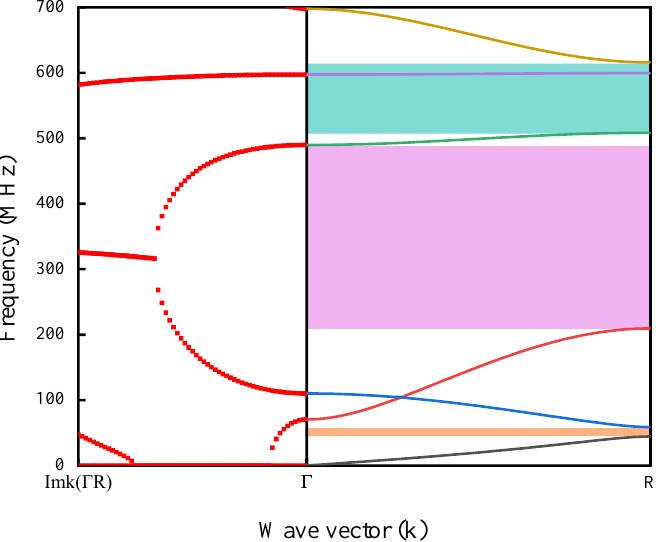
Figure 2. Complex energy band curve of the H-RPC structure. The real wave vector energy band curve in ( Г -R) direction is represented by solid lines of different colors on the right side, and the imaginary wave vector energy band curve in ( Г -R) direction is represented by red dotted lines on the left side.